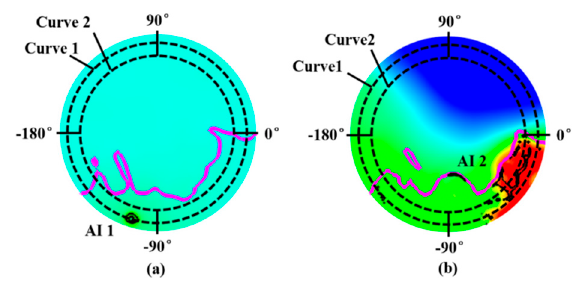
Figure 11. Schematic of trace from which the 1D profile is extracted. (2). Combustion characteristics at ω =